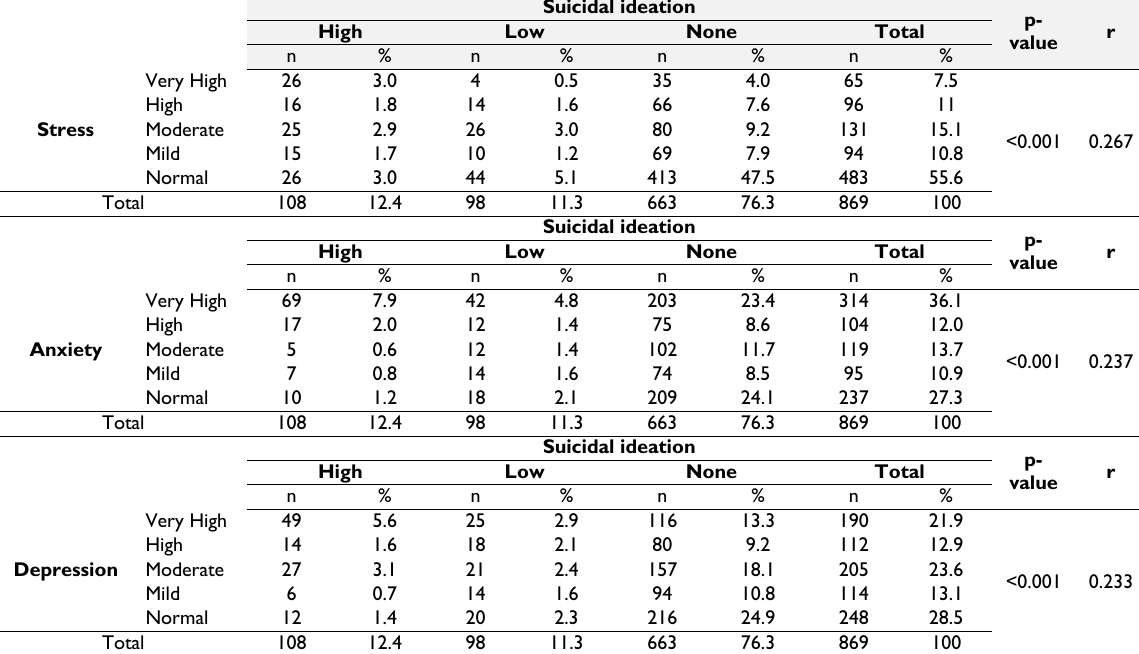
Table 2 Spearman rank correlation analysis of stress, anxiety, and depression with suicidal ideation